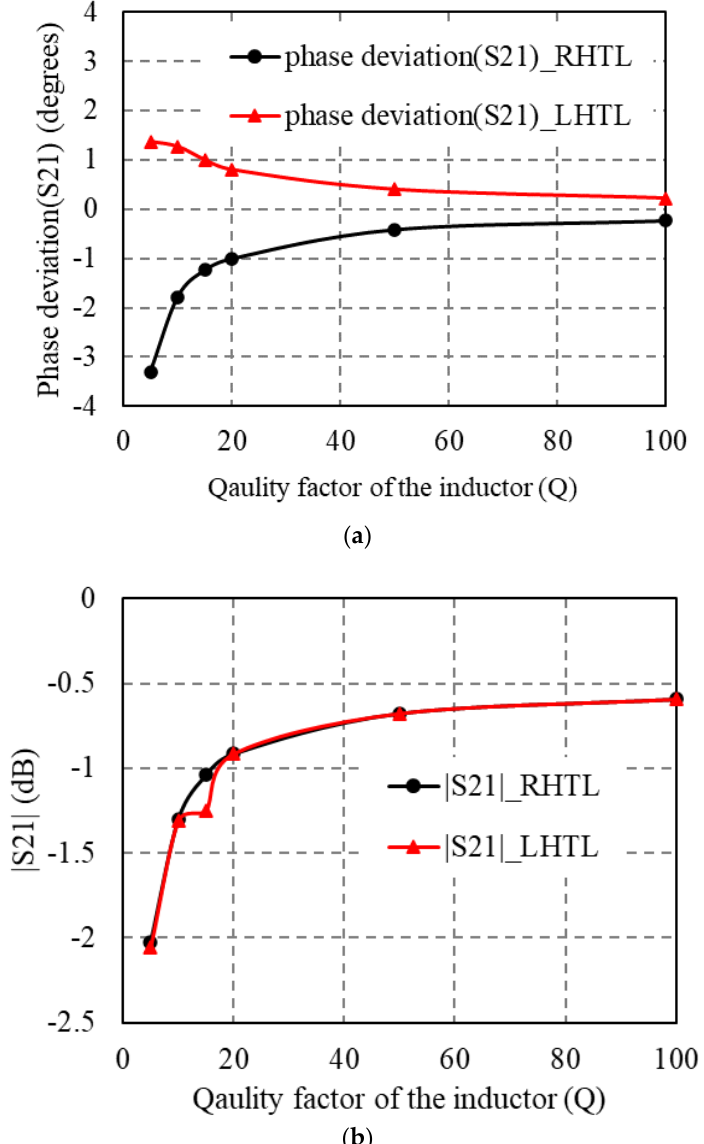
Figure 7. Magnitude and phase deviation of the left − and right − handed transmission lines. (a) Phase deviation of | S 21 | and (b) magnitude of |S 21 |